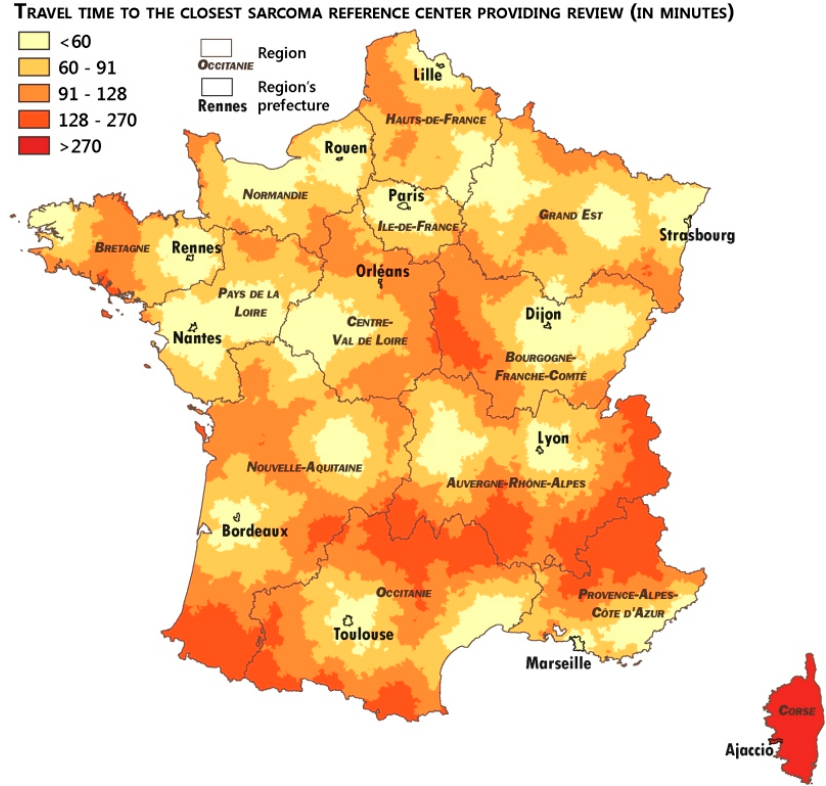
Figure 3. Access to pathological clinical expertise by mainland French communes.